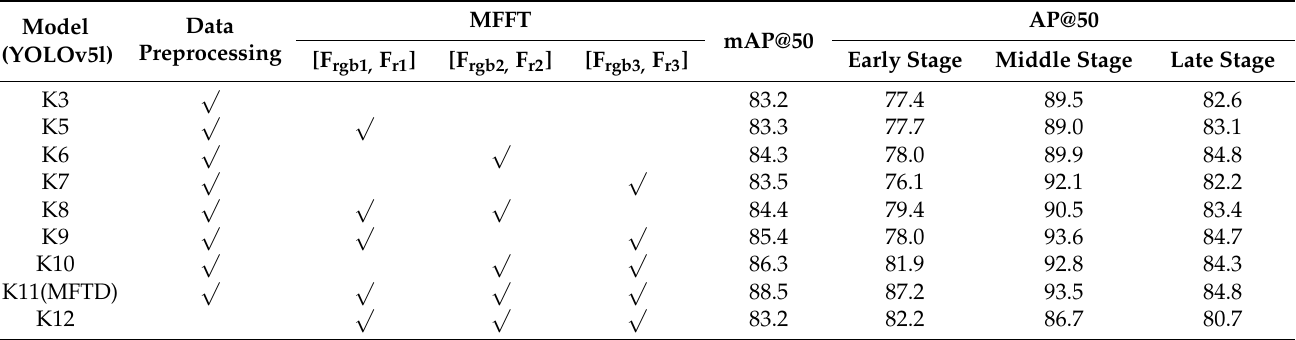
Table 6. Ablation Experiments on KP Dataset.